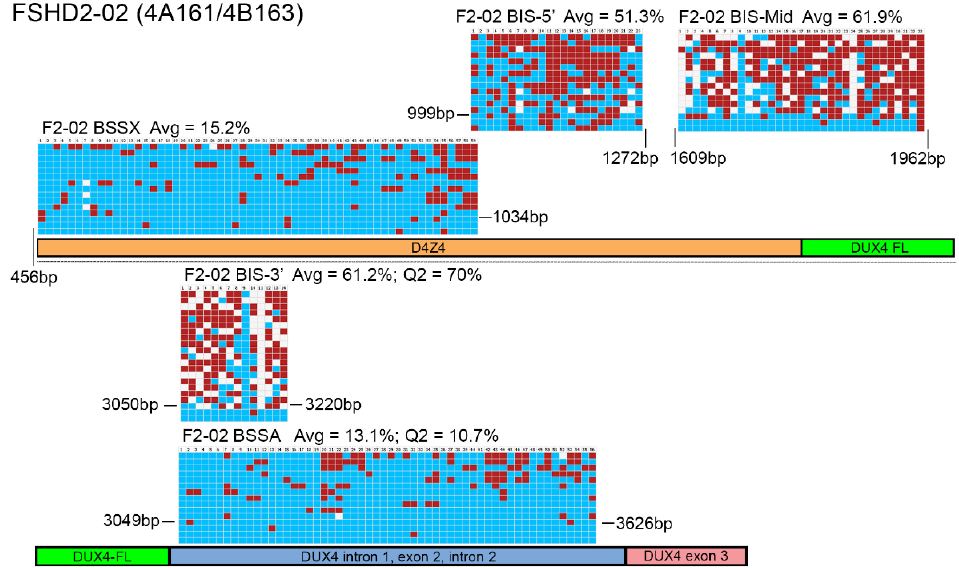
Figure 3. BSS analysis comparison of FSHD1 epigenetic signatures. BS-converted DNA from a ge- netically confirmed FSHD1 subject (F1-01) was analyzed using the BSSA, BSSX, BIS-5′, BIS-Mid, and BIS-3′ assays. Each BS graphic representation is shown approximately where it aligns with each part of the 4q35 D4Z4 array including the D4Z4 (orange), DUX4-fl ORF (green), DUX4 Intron 1, Exon 2, Intron 2 (purple), and Exon 3 (pink), with exact location indicated by base pairs (bp) downstream from the Kpn I site of the distal D4Z4 RU. Blue boxes indicate unmethylated CpGs, red boxes indicate methylated CpGs, and white boxes indicate no CpG where one is expected. Average methylation percentages are denoted “Avg” and have values of 37.6% for BSSX, 64.7% for BIS-5′, 70.6% for BIS-Mid, 62.2% for BIS-3′, and 30.9% for BSSA. This FSHD1 subject has a haplotype of 4A161/4A161. Therefore, the diagnostic methylation percentages for the first quartile (Q1) are included for BSSA (0.9%) and BIS-3′ (50%) for comparison.